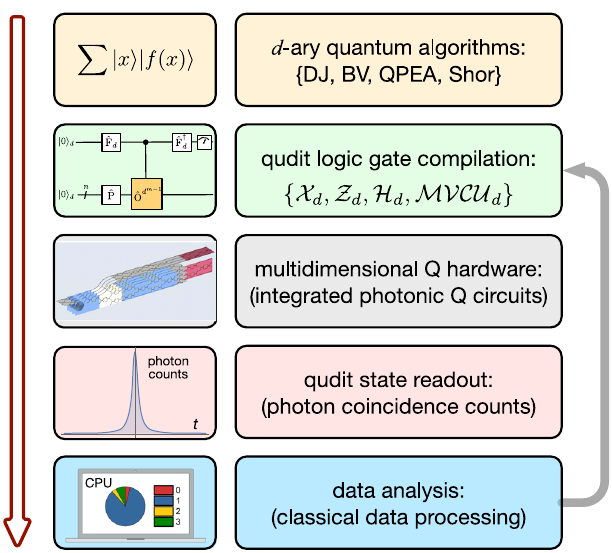
Fig. 1 The top-down hierarchy of qudit-based quantum